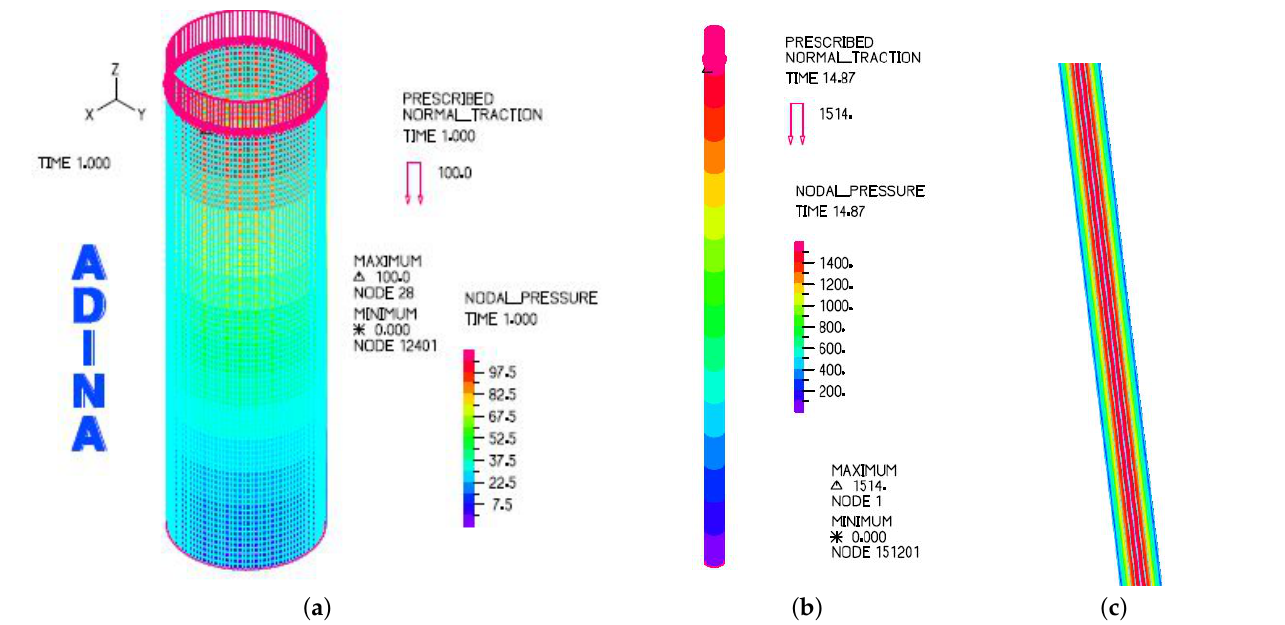
Figure 4. ( a ) Pressure and surface mesh. ( b ) Long plunger. ( c ) Annulus velocity